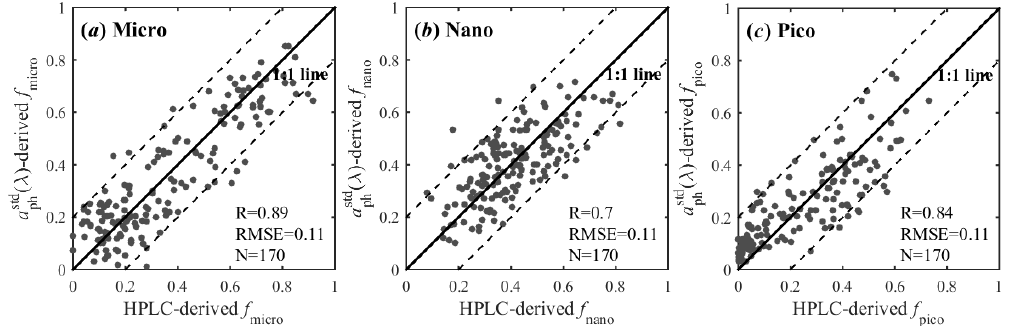
Figure 3. Comparison between in situ a std ( λ) -derived and HPLC-derived PSC for micro- (a) , nano- (b) , and pico-phytoplankton (c) . Dashed ph lines represent the ± 20% fraction range relative to the 1:1 line.